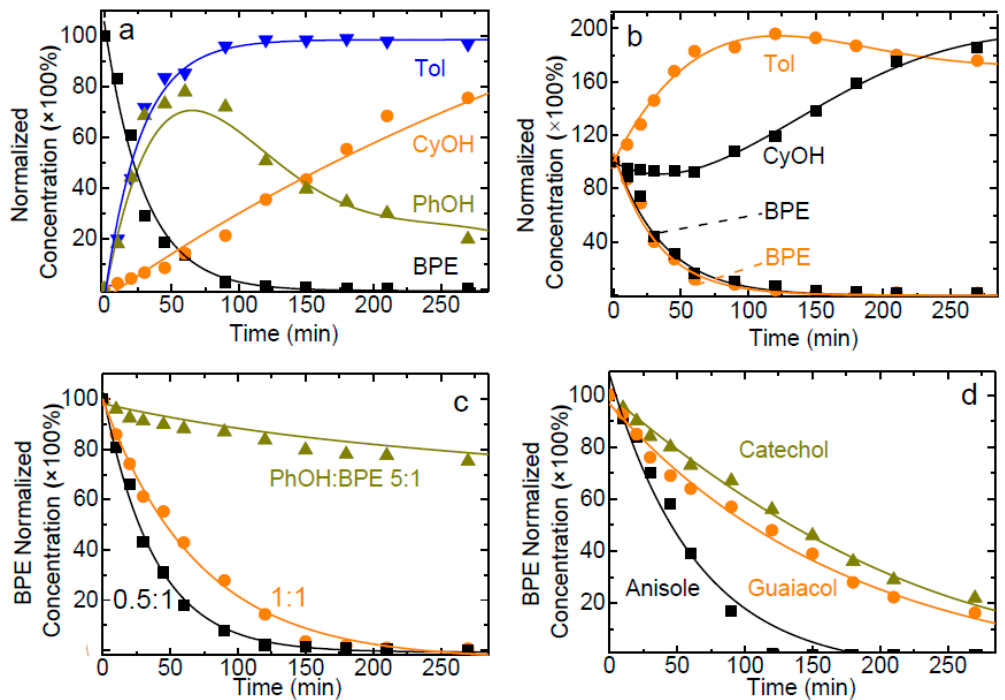
Figure 4. Kinetic profiles for benzyl phenyl ether (BPE) hydrogenolysis with mesoNi in a batch reactor: ( a ) with no reaction products, ( b ) in the presence of a reaction product (toluene or cyclohexanol, 1 equiv.), ( c ) in the presence of various amounts of phenol (5, 1, and 0.5 equiv.); ( d ) in the presence of anisole, catechol or guaiacol (1 equiv.). Normalized concentrations were measured by GC-FID using an internal standard. Reaction conditions: 120 °C, 20.0 mg catalyst, 80 mL 2-PrOH as both solvent and H-donor, pressure 4 MPa, 5.0 mmol L − 1 BPE, stirring at 650 rpm.